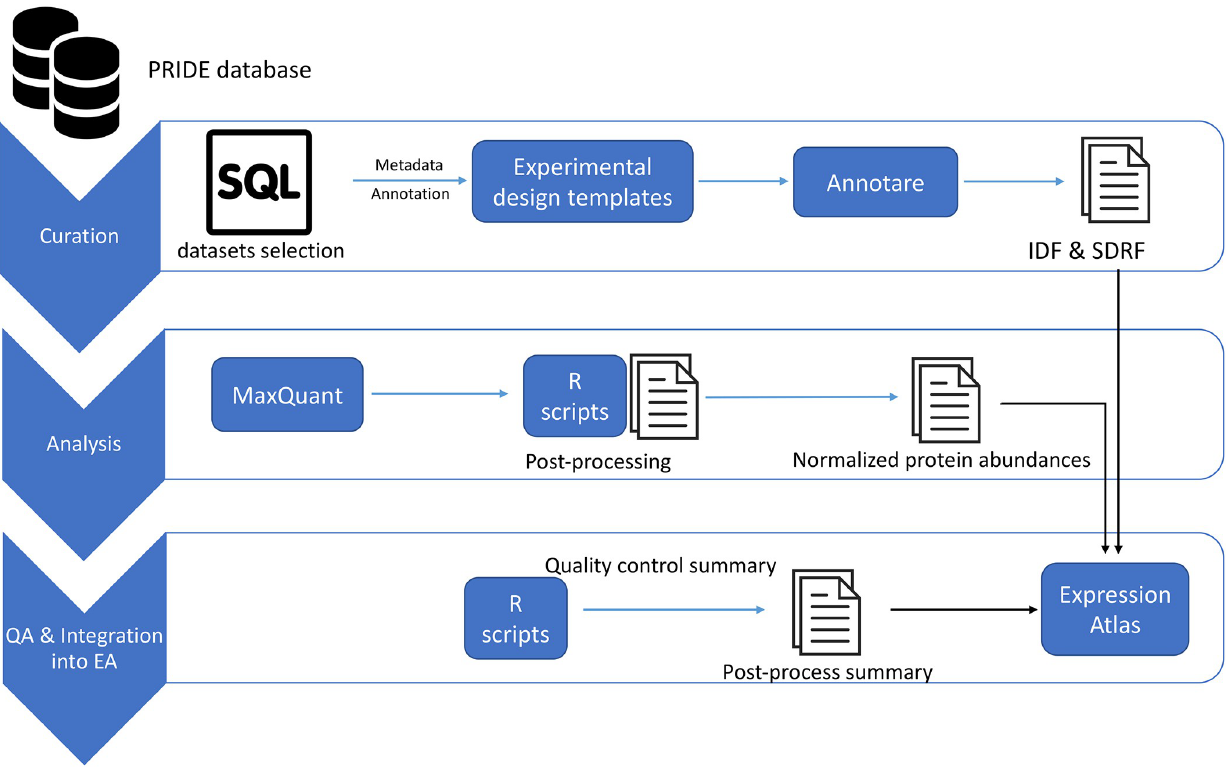
Fig 1. An overview of the study design and reanalysis pipeline. QA: Quality assessment.